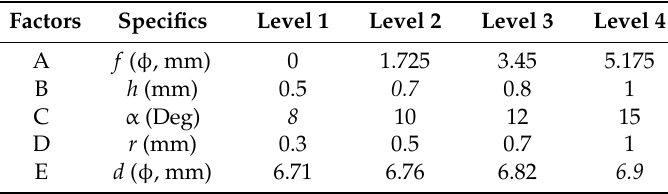
Table 2. Five factors and three levels of the orthogonal array L 16 (3 5